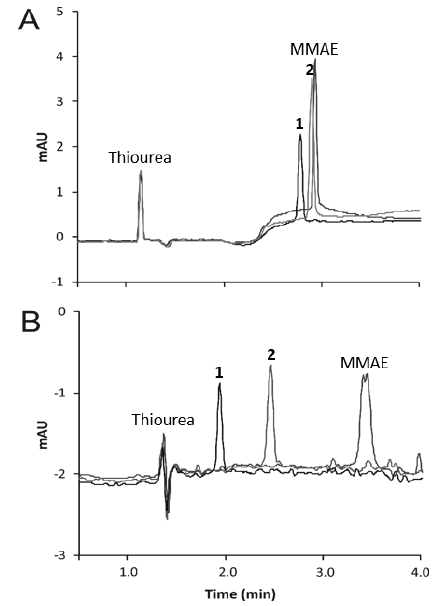
Figure 3. MEKC separation of the studied cytotoxic agents using ( A ) 20 mM SDS and ( B ) 20/40 mM of SDS/SC. The experimental conditions are similar to those in Figure 2.